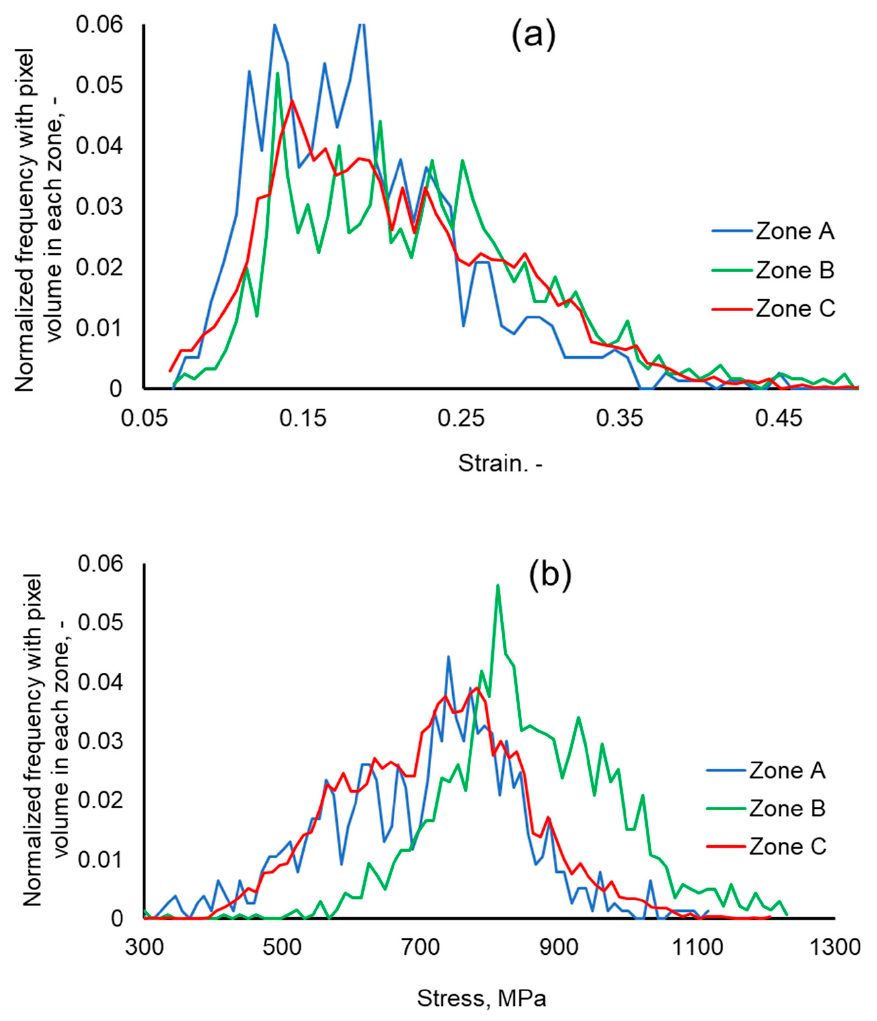
Figure 11. The normalized frequency of ( a ) strain and ( b ) stress for each zone identified in Figure 10.